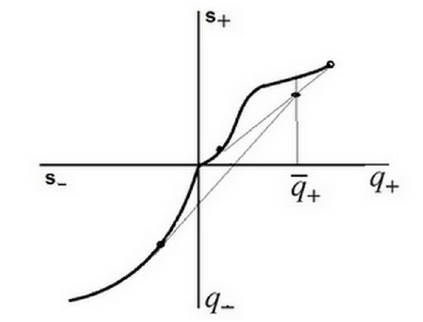
Figure 2. The non-convex dependency